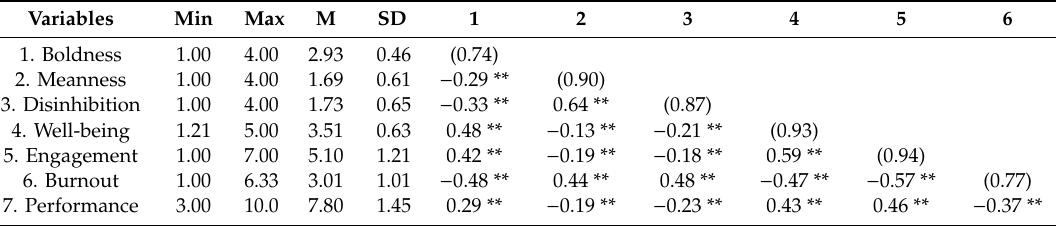
Table 1. Descriptive statistics for Sample 1 (managers) at Time 1 ( N = 651).